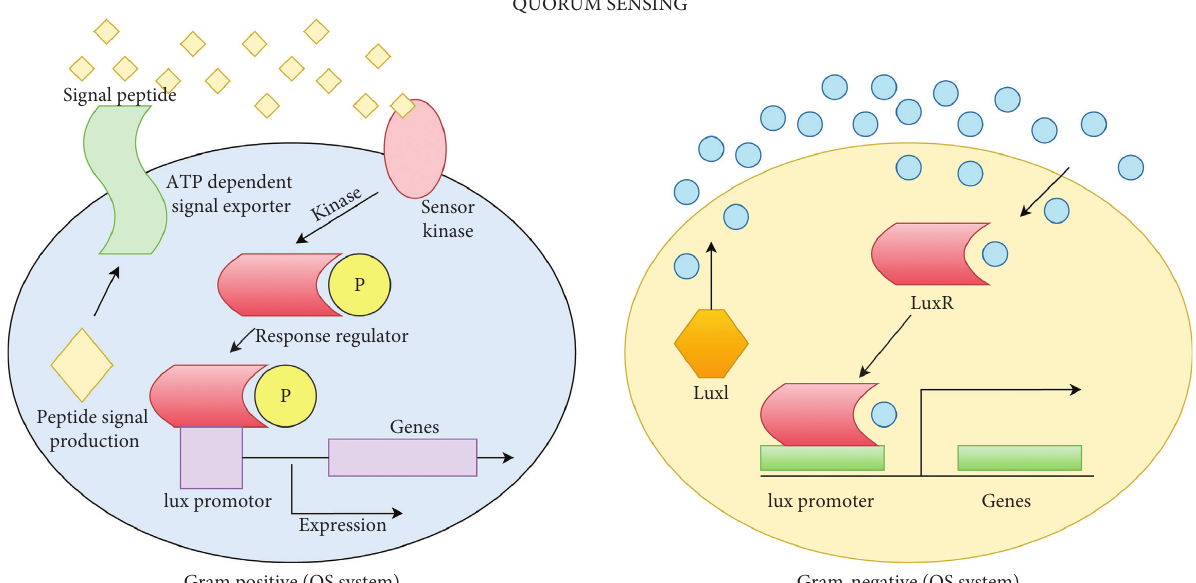
Figure 1: Quorum sensing arrangement in gram-positive and gram-negative